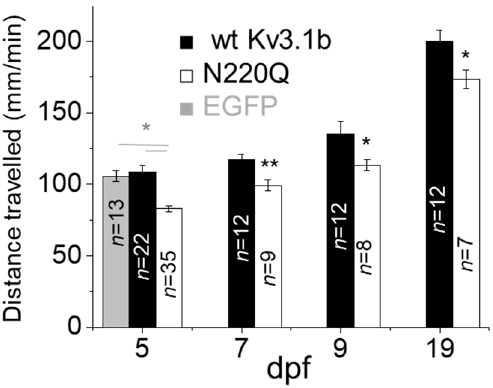
Figure 3. N-Glycosylation site vacancy of Kv3.1b retards motor activity in zebrafish. Average dis- tance travelled per minute of larvae expressing EGFP, WT Kv3.1b or N220Q Kv3.1b in CaP neu- rons. Data are presented as the mean ± SEM and were compared by one-way ANOVA (* p < 0.01) and Student’s t-test (* p < 0.05, ** p < 0.01) for groups of more than two or two, respectively.